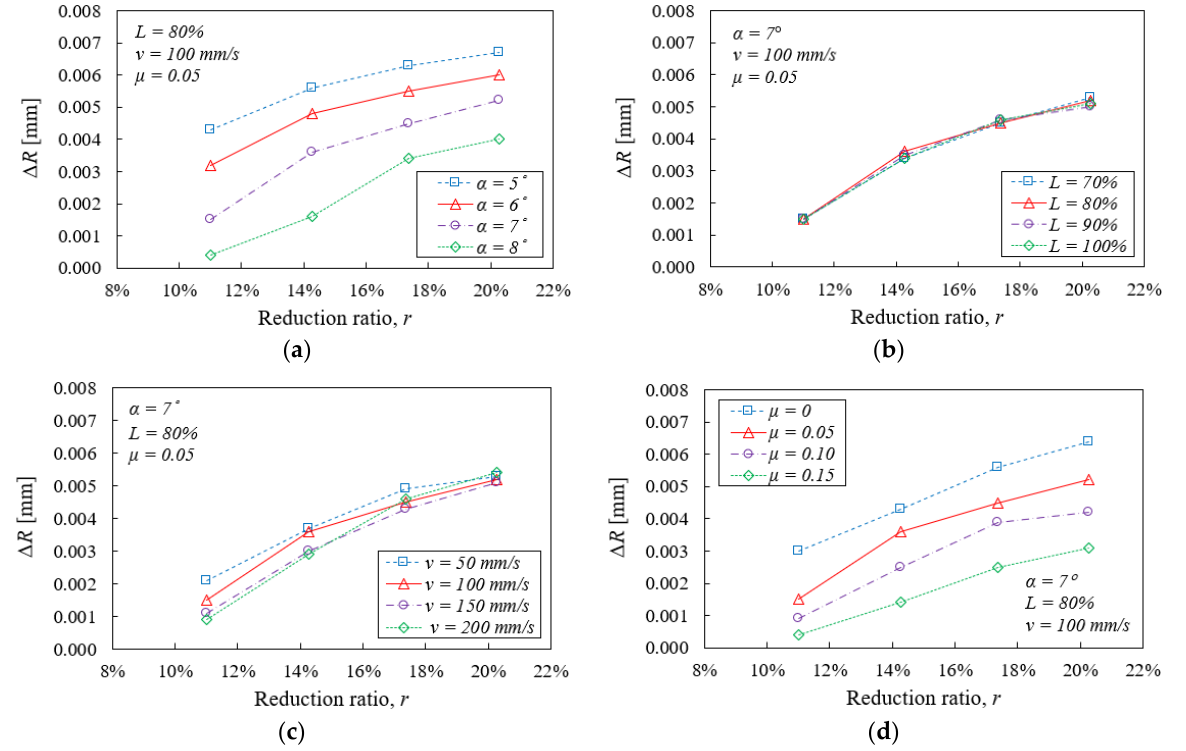
Figure 8. Effects of reduction ratio on ∆ R under different conditions. ( a ) Different semi-die angles; ( b ) different bearing ratios; ( c ) different drawing speeds; ( d ) different friction coefficients.